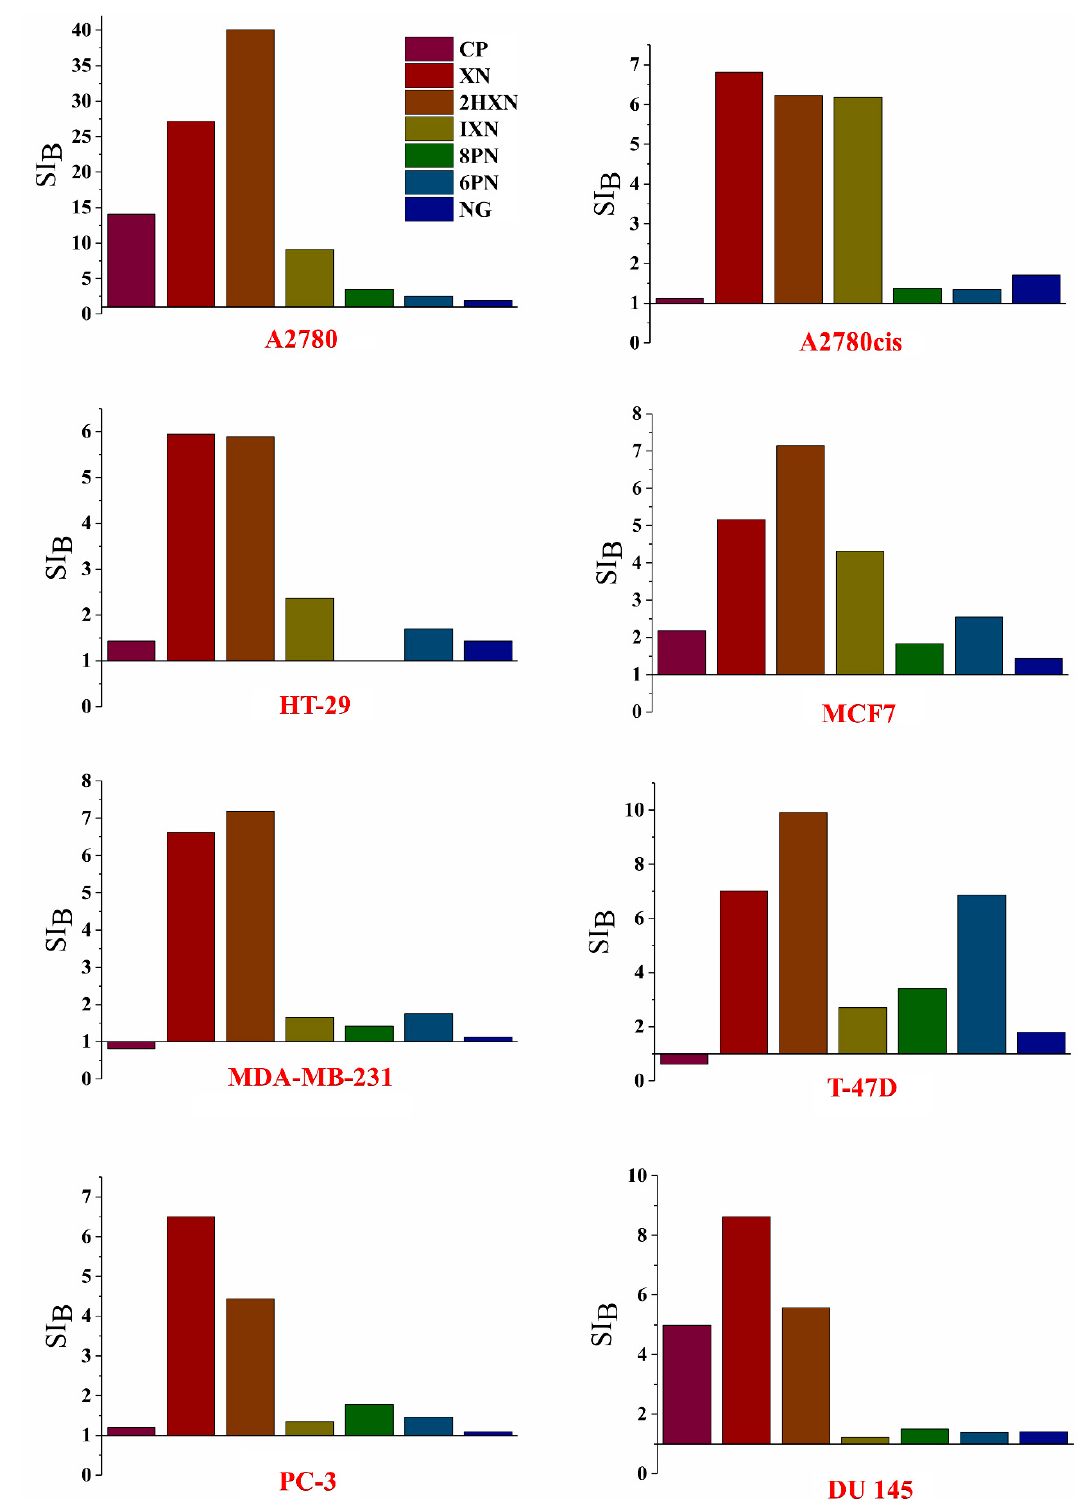
Figure 4. The selectivity indexes (SI B ) which represents IC 50 for a normal cell line (MCF 10A) /IC 50 and for a cancerous cell line.